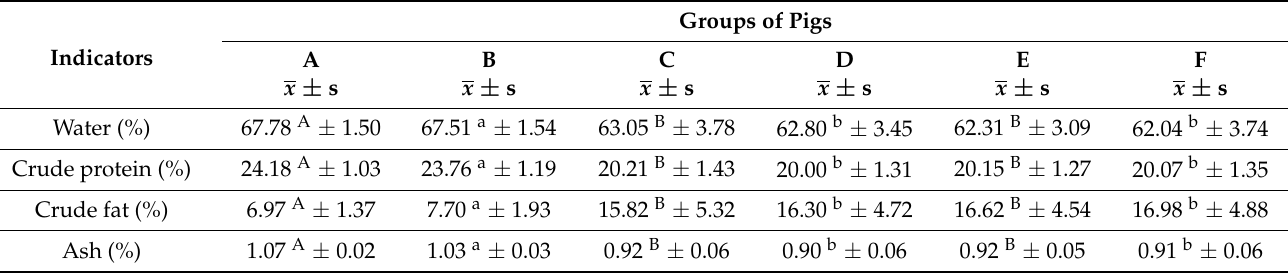
Table 10. Chemical composition of the